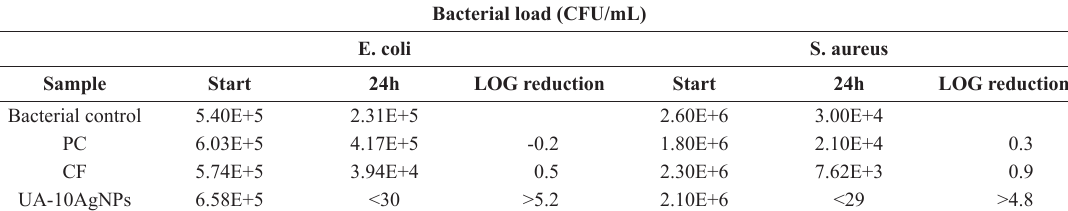
Figure 6. Contact angle images of water drop on (a) CF, (b) UA-1AgNPs, and (c) UA-10AgNPs. Table 4. Antibacterial activities of UV-cured